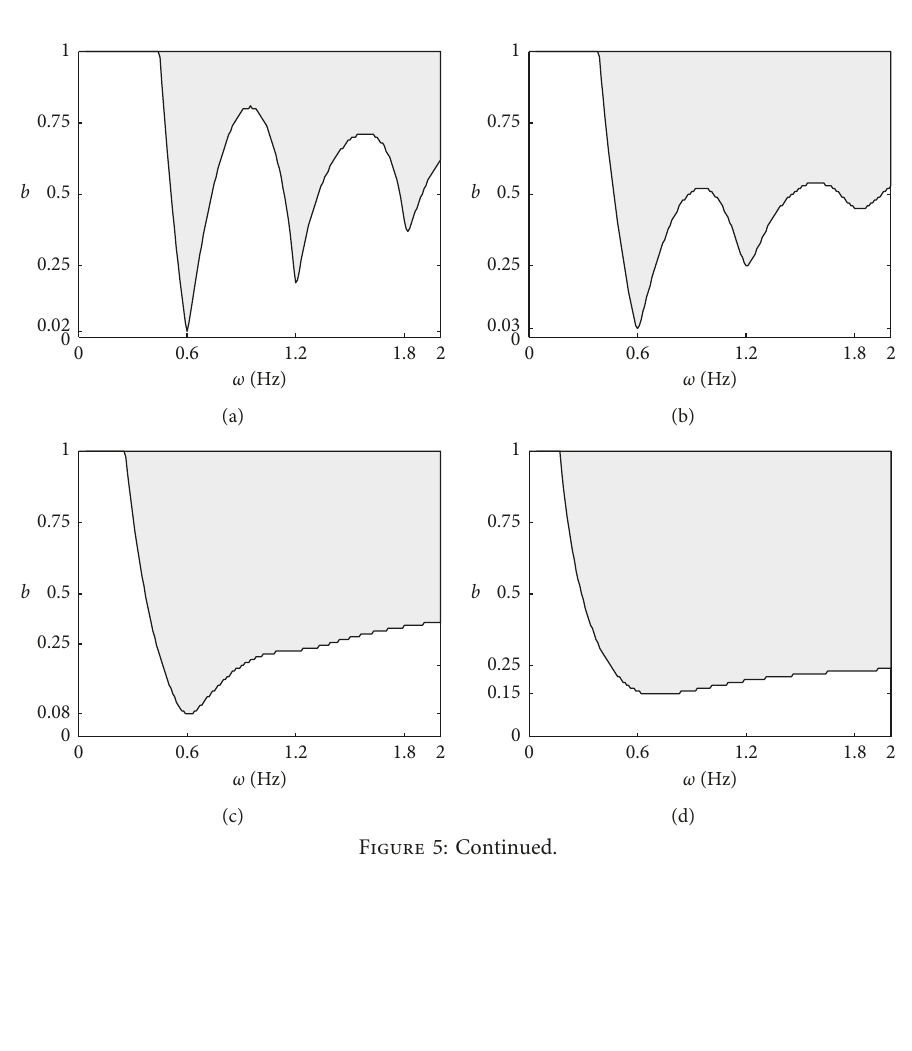
0 . 005 and (cid:29)